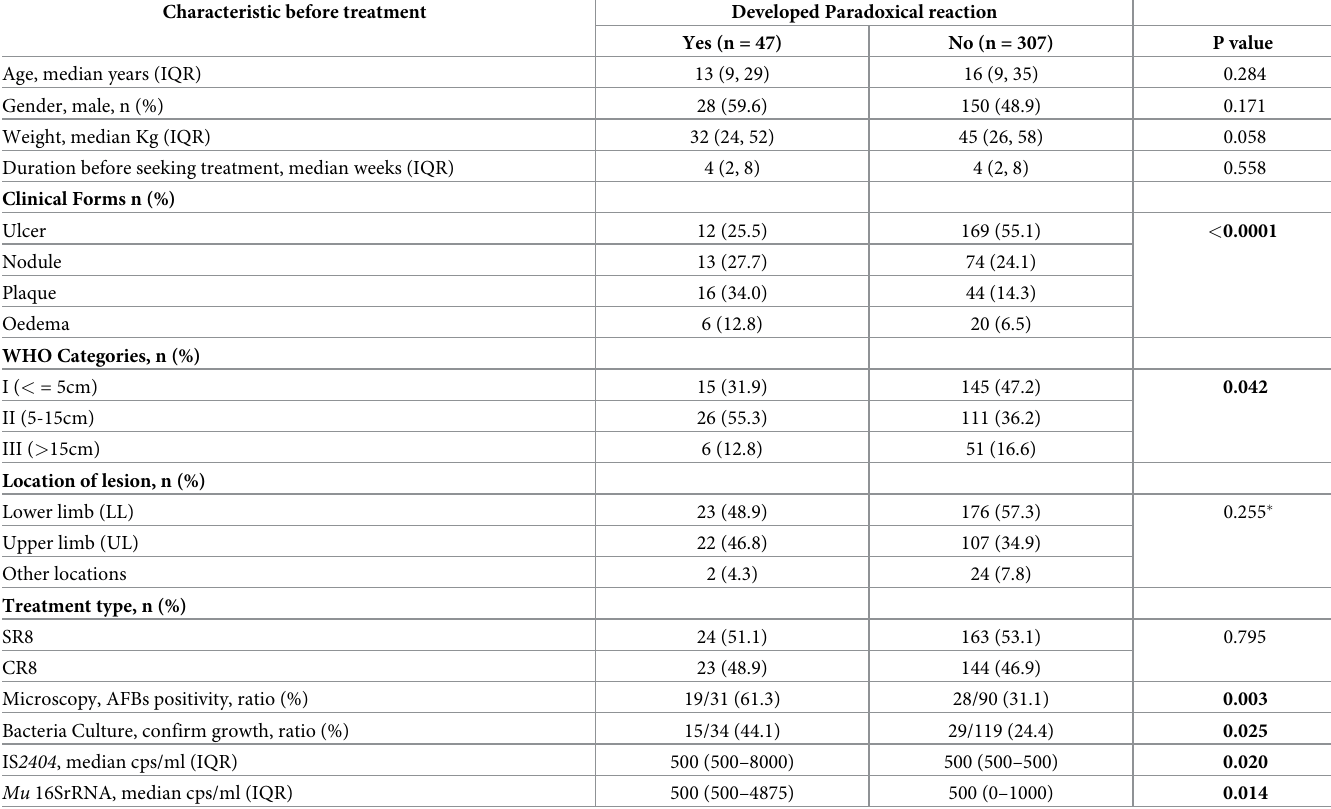
Table 1. Comparison of baseline characteristics of study participants between those who developed paradoxical reaction and those without paradoxical reaction. Characteristic before